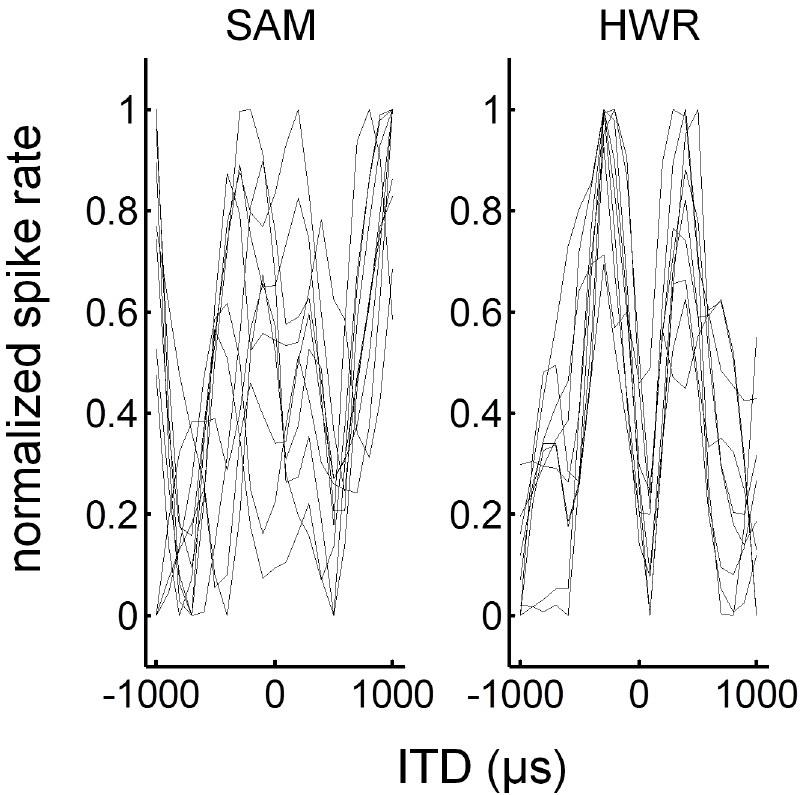
Figure 13. ITD functions in deaf animals with cochlear implants. Examples of normalized ITD functions in response to SAM and HWR pulse trains. Each ITD response function was derived from evenly spaced recording locations along the same electrode penetration, positioned orthogonal to the cortical surface (as in Figure 7).